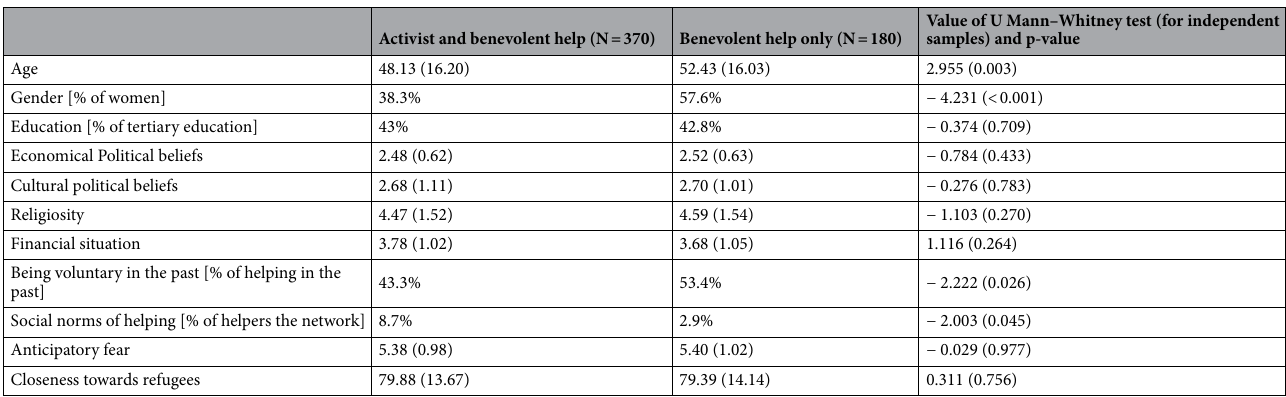
Table 3. Differences between groups delivering different types of support. Values provided in columns are means with standard deviations (in parentheses) or percentages in a given